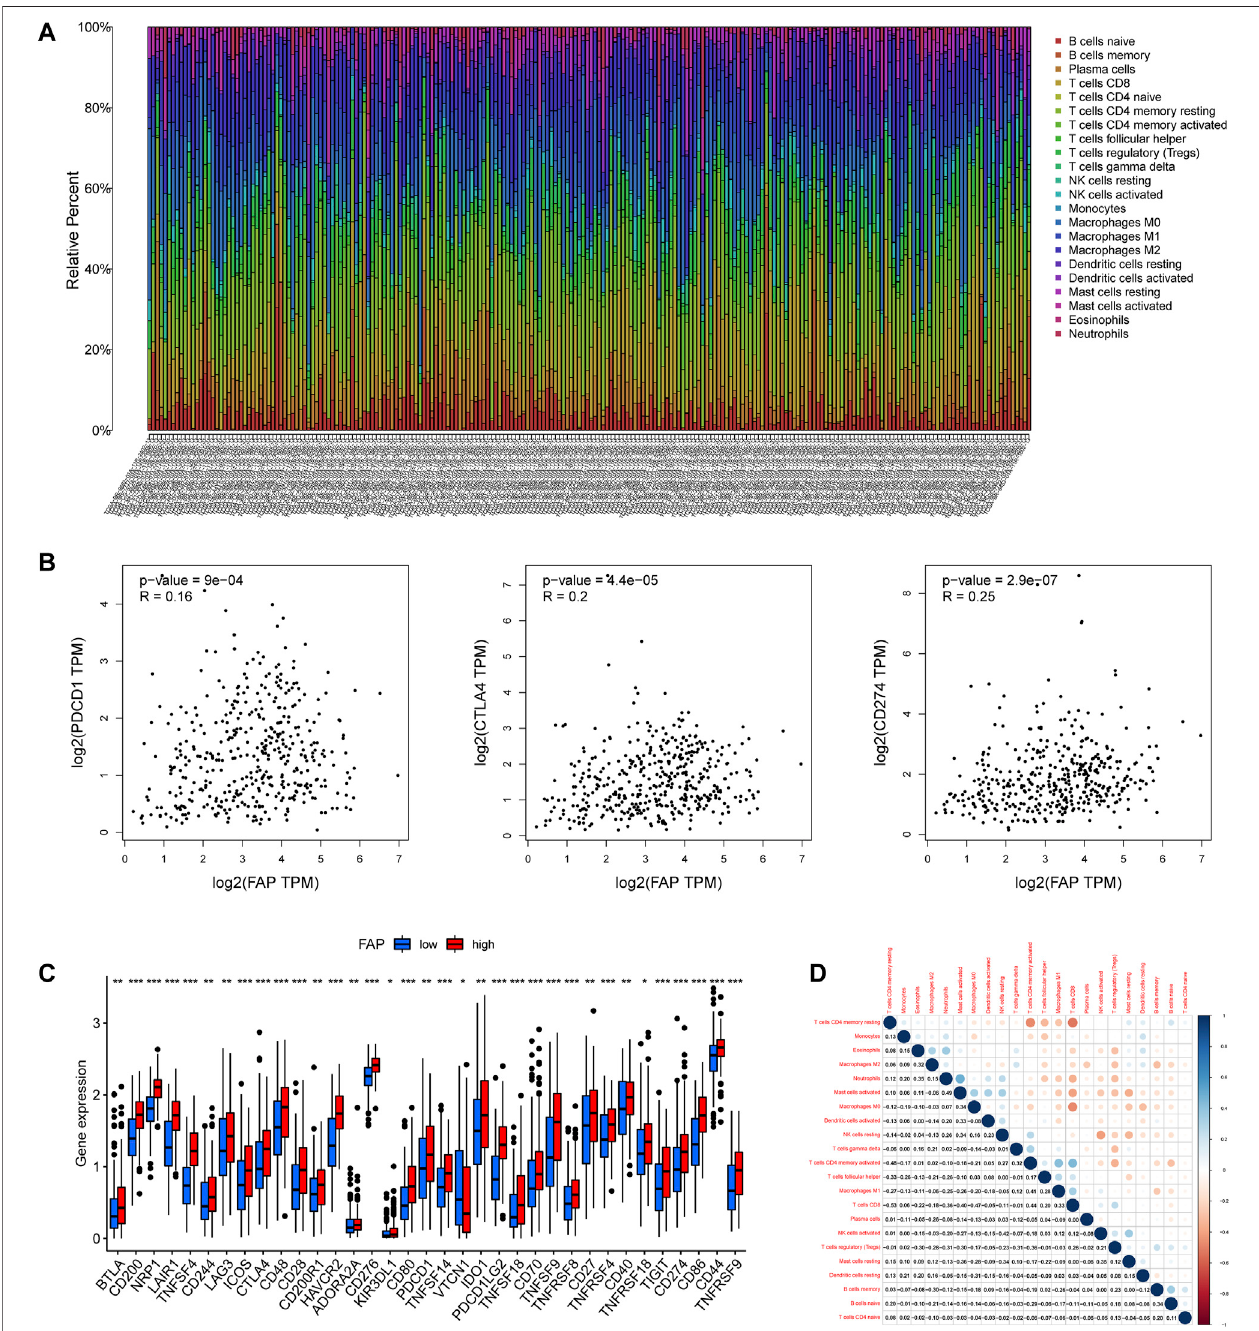
FIGURE 3 | Landscape of the TME in STAD and characteristics of different FAP expression levels. (A) Proportions of TME cells among patients with STAD in the TCGAcohort. (B) CorrelationplotsshowingcorrelationsbetweenFAPexpressionandexpressionofPDCD1,CTLA4,andCD274inSTADpatients. R =linearcorrelation coef fi cient. P = p -value of linear correlation. (C) Expression levels of immune checkpoint genes in FAP-high and FAP-low groups; * p < 0.05, ** p < 0.01, *** p < 0.001. (D) Correlation analysis was used to assess relationships among immune cells.